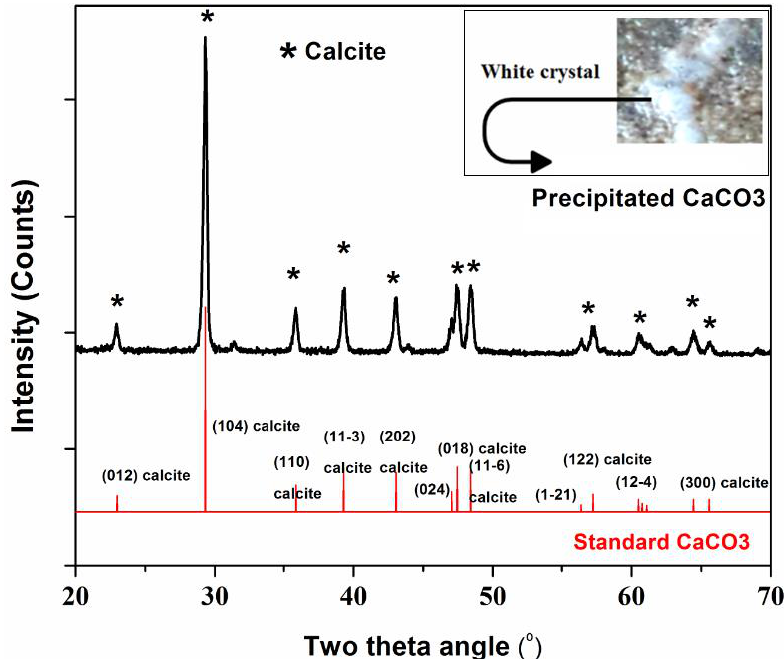
Figure 9. XRD image of the precipitated Calcite (CaCO 3 ) by bacteria.